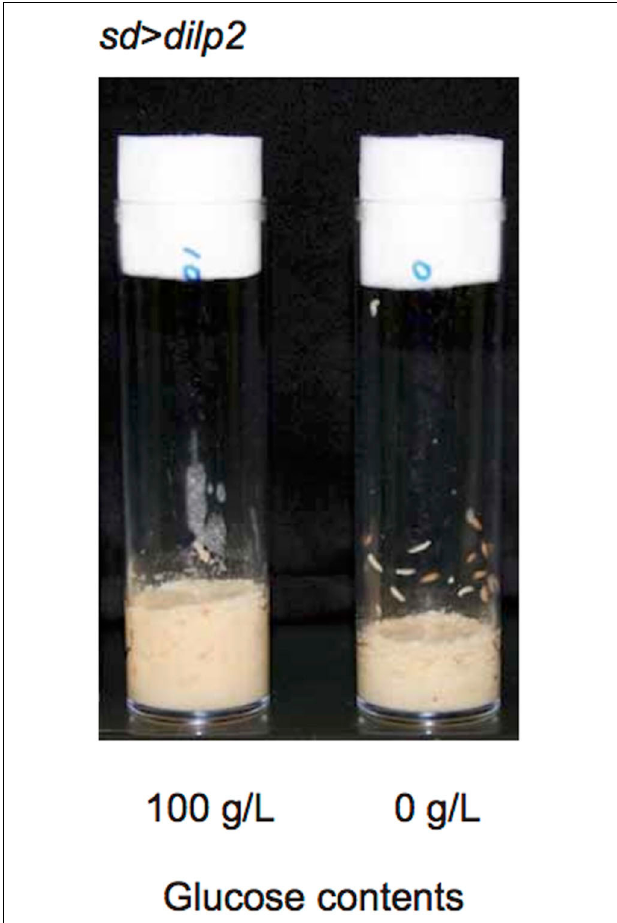
FIGURE 12 | dilp2 -overexpressing flies develop faster in media with reduced glucose. Overexpression of dilp2 retarded development of flies when they were reared on the standard media containing 100g/L glucose (left). However, flies develop faster when kept in glucose-deprived media (right). The mean ( ± SE) durations of egg-to-early pupa was 106 . 3 ± 1 . 3 and 82 . 6 ± 1 . 3h, with control media and glucose-deprived media, respectively (Student t -test: p < 0 .